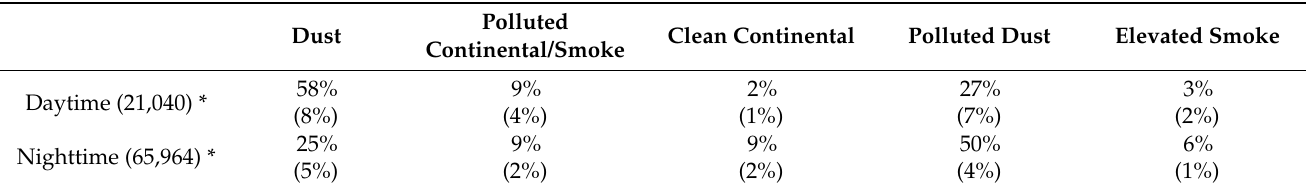
Table 1. The mean and standard deviation (in brackets) of the percentage of aerosol subtypes in the daytime and nighttime.